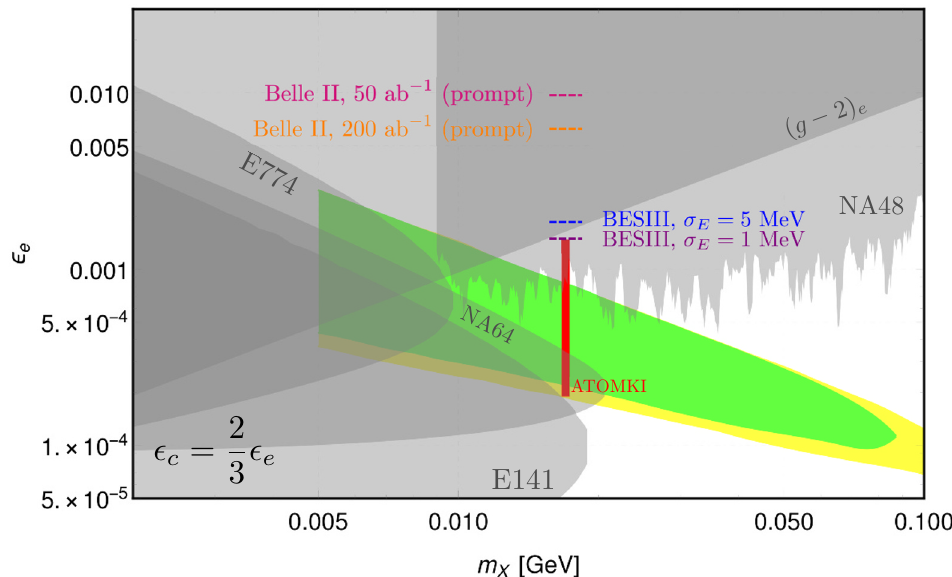
Figure 8 . The yellow (green) contour corresponds ≥ 2 σ significance assuming SM background B = 0 . 1 ( B = 1 ) from e + e − channel at Belle II with 50 ab − 1 luminosity, which probes rest of the favour parameter region of Atomki (red vertical band). The gray-shaded regions are excluded by current experiments relate to Xee coupling. Compare to the sensitivities of e + e − → ‘ + ‘ − + J/ Ψ → ‘ + ‘ − e + e − η c channel at Belle II and e + e − → J/ Ψ → e + e − η c channel at BESIII by assuming the kinematic mixing between X boson and photon, bringing the relation ε Belle II experiments 50, 200 ab − 1 in the 17 MeV mass region, the significance bounds are denoted by magenta, orange dotted lines, respectively. In the case of BESIII for the energy resolutions σ 1 MeV and 5 MeV, corresponding to section 3, they are denoted in purple and blue, respectively.